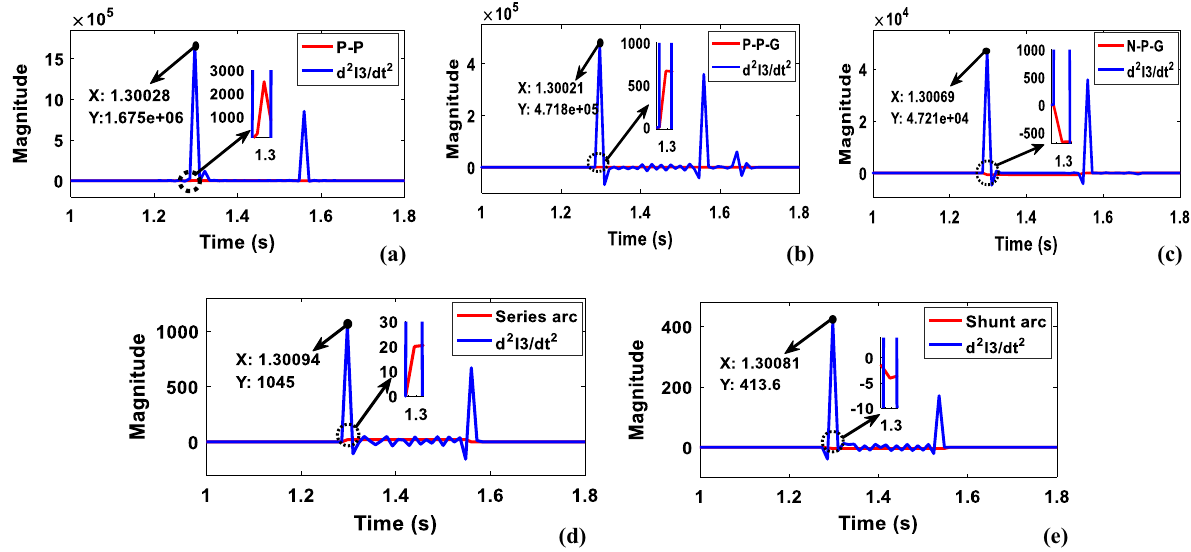
2 I 3 Fig. 12 Faults detection using d dt 2 under fault resistance variation a P-P fault, b P-P-G fault, c N-P-G fault, d series arc, e shunt arc